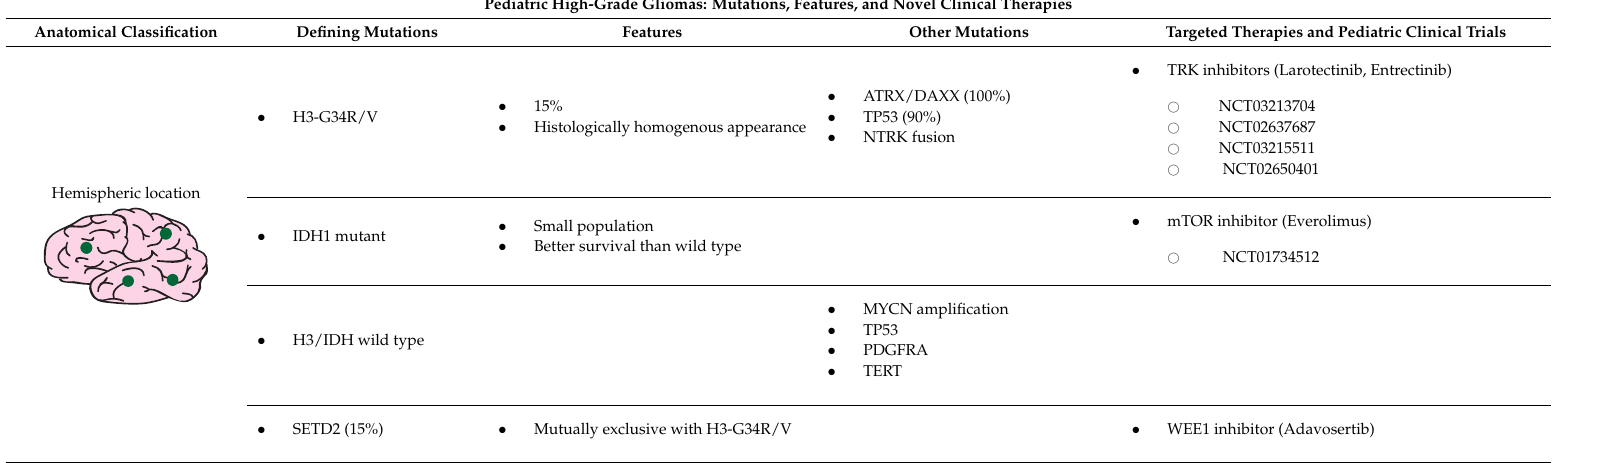
Pediatric High-Grade Gliomas: Mutations, Features, and Novel Clinical